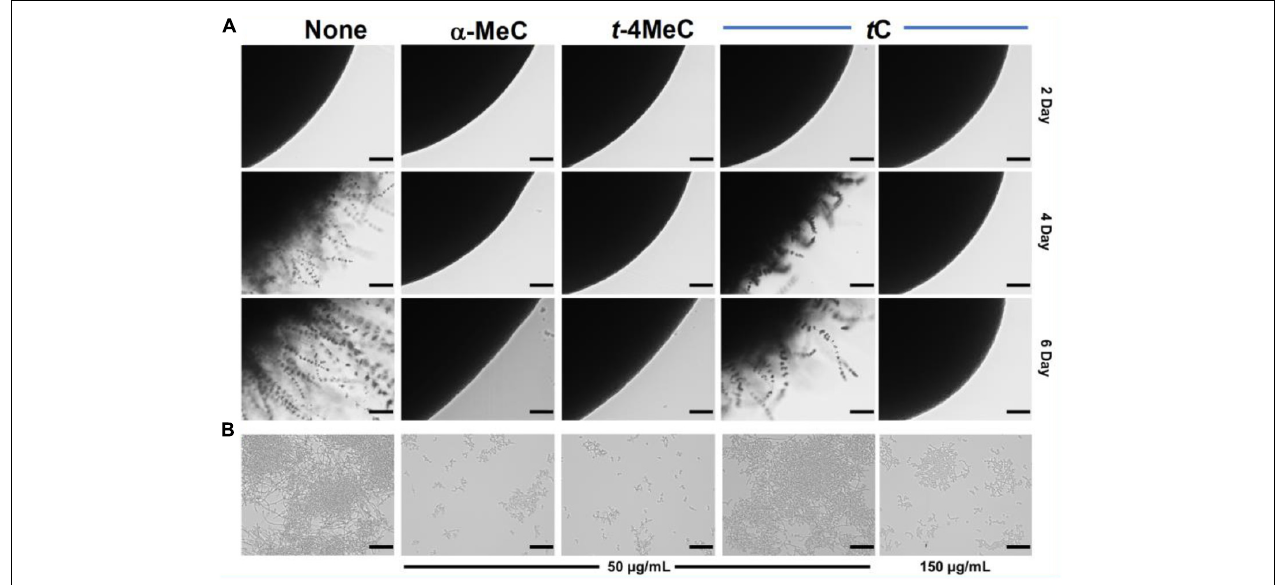
FIGURE 2 | Inhibition of hyphal filamentation and aggregation by α -methyl cinnamaldehyde ( α -MeC) and trans- 4-methyl cinnamaldehyde ( t -4MeC). C. albicans DAY185 was streaked onto PDA solid plates in the absence or presence of α -methyl cinnamaldehyde ( α -MeC; 50 µ g/mL), trans- 4-methyl cinnamaldehyde ( t -4MeC; 50 µ g/mL), or trans- cinnamaldehyde ( t C; 50 and 150 µ g/mL). Colony morphologies were observed periodically over 6 days at 37 ◦ C (A) , C. albicans DAY185 yeast-hyphae transition was assessed in PDB in the presence of α -methyl cinnamaldehyde ( α -MeC; 50 µ g/mL), trans- 4-methyl cinnamaldehyde ( t -4MeC; 50 µ g/mL), or trans- cinnamaldehyde ( t C; 50 and 150 µ g/mL) after incubation for 24 h (B) . The scale bars in panels (A,B) represent 100 µ m. None indicates the non-treated